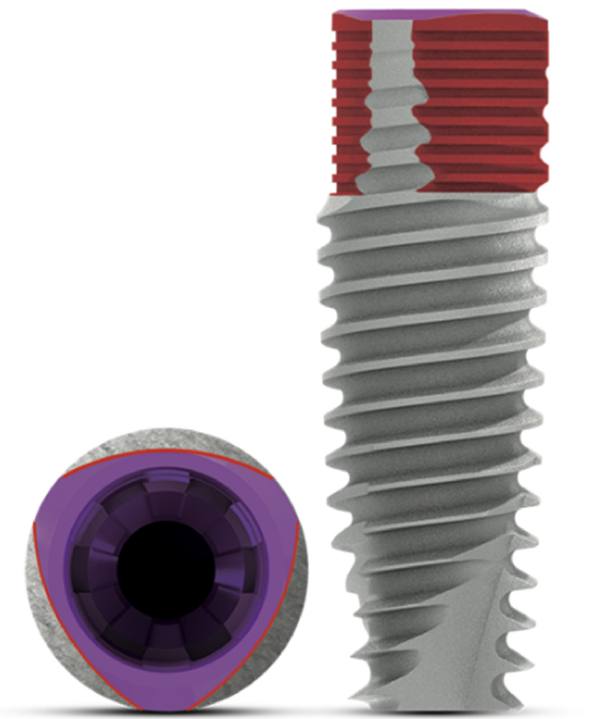
Figure 1. Conical connection platform and triangular shape of the coronal third of the V3 implant. The implants used were narrow platform 3.3 mm and standard 3.9 diameter implants with lengths ranging between 8- and 13-mm. Local anesthesia was administered using 4% articaine with 1:100,000 epinephrine (DFL, Rio de Janeiro, RJ, Brazil) then a full thickness flap was reflected using crestal incision. After performing the osteotomy in accordance with the recommendations of the manufacturer, the implants were placed in the healed bone ridge in such a way that the flat area was oriented toward the labial aspect of the ridge extending the implant away from the buccal crestal bone, as illustrated in (Figure 2). Insertion torque was ≥ 30 Ncm and sub-crestal placement did not exceed 0.5 mm on the buccal side; no regenerative procedure was performed. The flap was sutured using 5-0 monofilament nylon suture (Ethicon, Johnson & Johnson, New Brunswick, NJ, USA). A transgingival healing was allowed. Postoperative instructions included 25 mg of dexketo- profen for 2 days and local irrigation of chlorhexidine 0.12%, three times a day for 7 days. The patient returned one week after surgery for suture removal and postoperative assess- ment. Minimal pain and edema on the surgical site were observed with no signs of infection or adverse reactions. All patients receive a post-operative oral hygiene instruction, supra- and subgingival debridement using ultrasonic and hand instruments in the dentition after 1, 4 and 12 weeks of